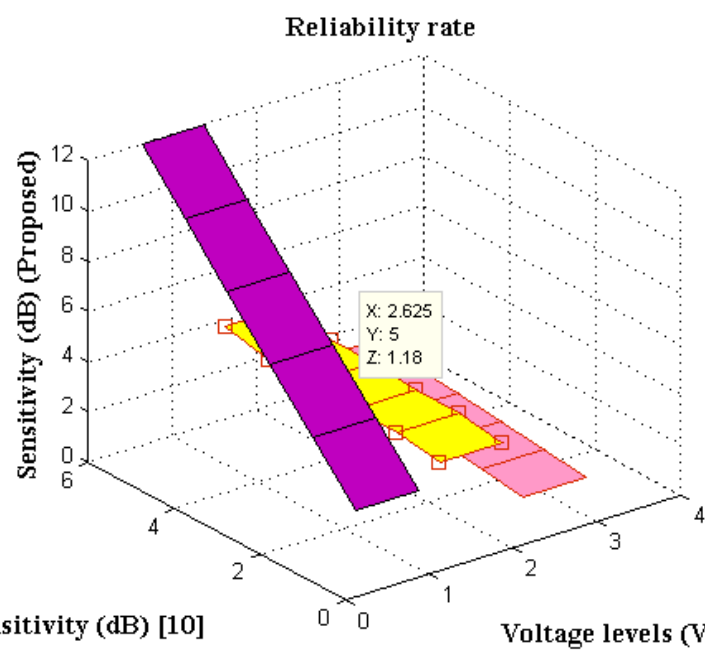
Figure 5. Reliability of proposed method.